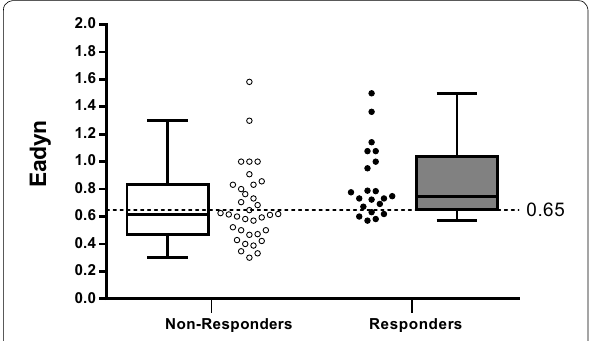
Fig. 3 Box plot (median values, inter‑quartile range) and individual values of dynamic arterial elastance (Eadyn) before and after volume expansion in pressure responders (volume expansion induced increase in mean arterial pressure